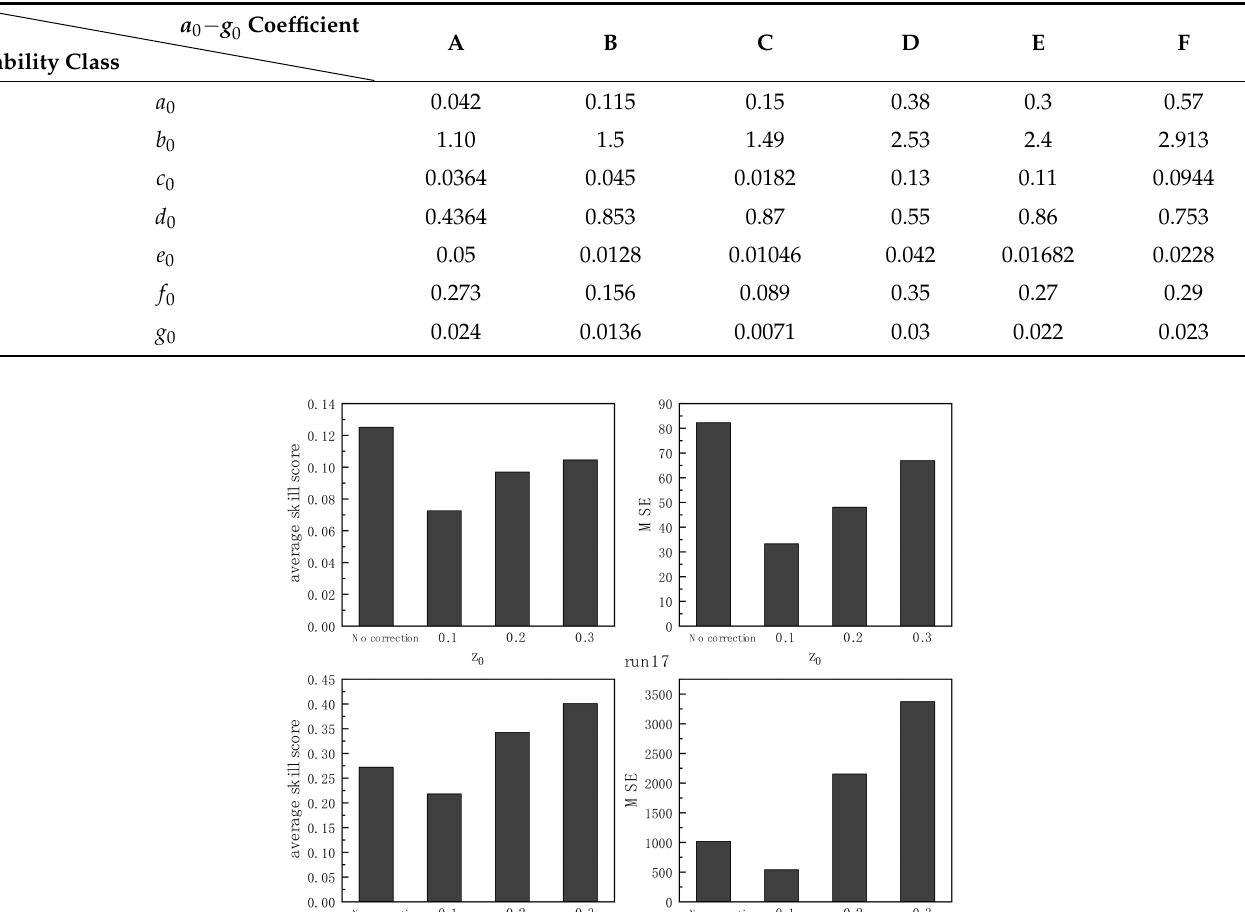
Table 5. The value of the coefficient a 0 – g 0 .